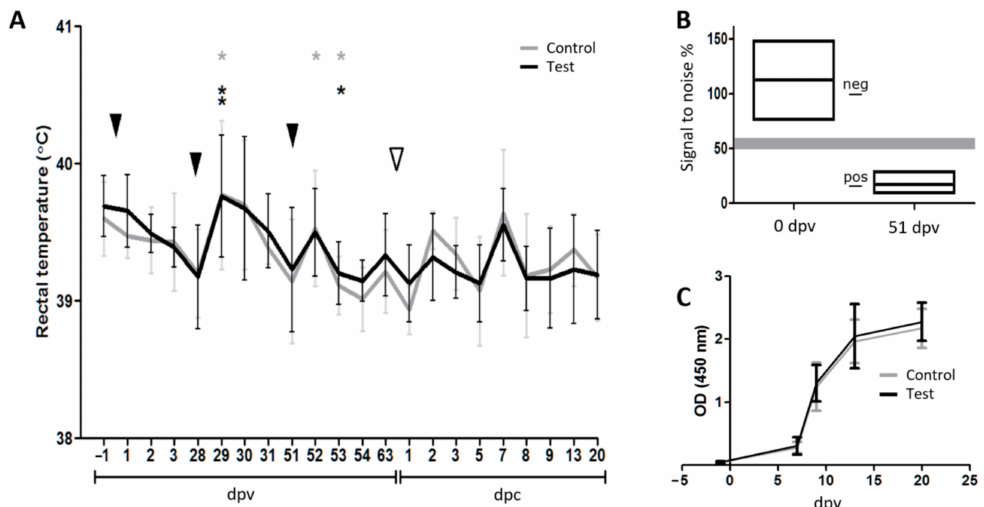
Figure 4. The vaccination challenge trial. ( A ) Rectal temperature throughout the experiment. The black and grey lines represent the average temperatures of the test group and the control group, respectively. Error bars indicate the standard deviations. The black arrowheads indicate the vaccination events. The white arrowhead indicates the challenge of the pigs with PRRSV-2. Before challenge, asterisks indicate group-wise temperature peaks that are significantly different from the previous day calculated using a two-tailed paired Student’s T -test (*: 0.05 ≥ p > 0.01; **: 0.01 ≥ p > 0.001). After challenge, no significant differences in body temperature were observed between the two groups as calculated using a two-tailed unpaired Student’s T -test. ( B ) Seroconversion following vaccination. Box diagram of the anti-E2 inhibition ELISA performed at dpv 0 and dpv 51 illustrating that the pigs responded to the vaccine vector by producing antibodies against the classical swine fever virus (CSFV) protein E2. The upper and lower edges of the boxes represent maximum and minimum signal-to-noise percentage values, respectively. The mean values are represented by the middle lines. The positive (11, 85) and negative (100) control values are indicated by lines in the space between the two boxes. The shaded area represents the threshold range. Note that no data points were observed in this area. ( C ) Seroconversion to PRRSV following challenge infection. Line diagram of the PRRSV Ab ELISA showing that all pigs responded to the challenge by producing antibodies against PRRSV